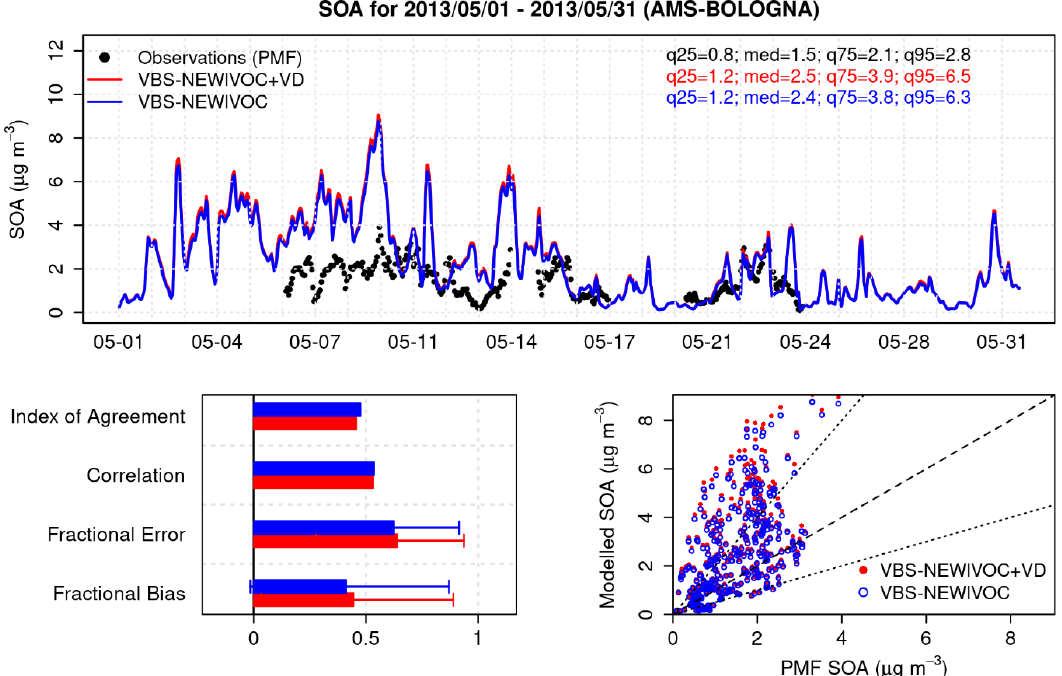
Figure 11. Comparison among modeled and observed (PMF results, black) SOA concentrations in May 2013 at the Bologna site: VBS scheme with new parameterizations for IVOC emissions (VBS_NEWIVOC, blue) and VBS scheme with new parameterizations for IVOC emissions and revised volatility distribution (VBS-NEWIVOC+VD, red).